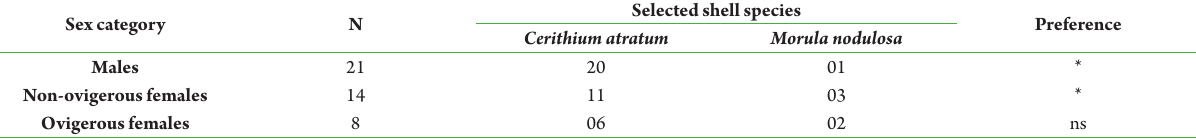
Selected shell species